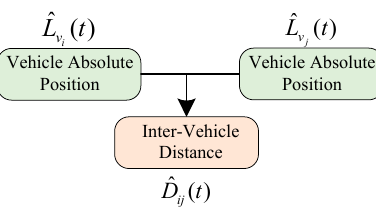
Figure 2. Flowchart of Absolute Position Differencing (APD)-based inter-vehicle distance (IVD) estimation method.